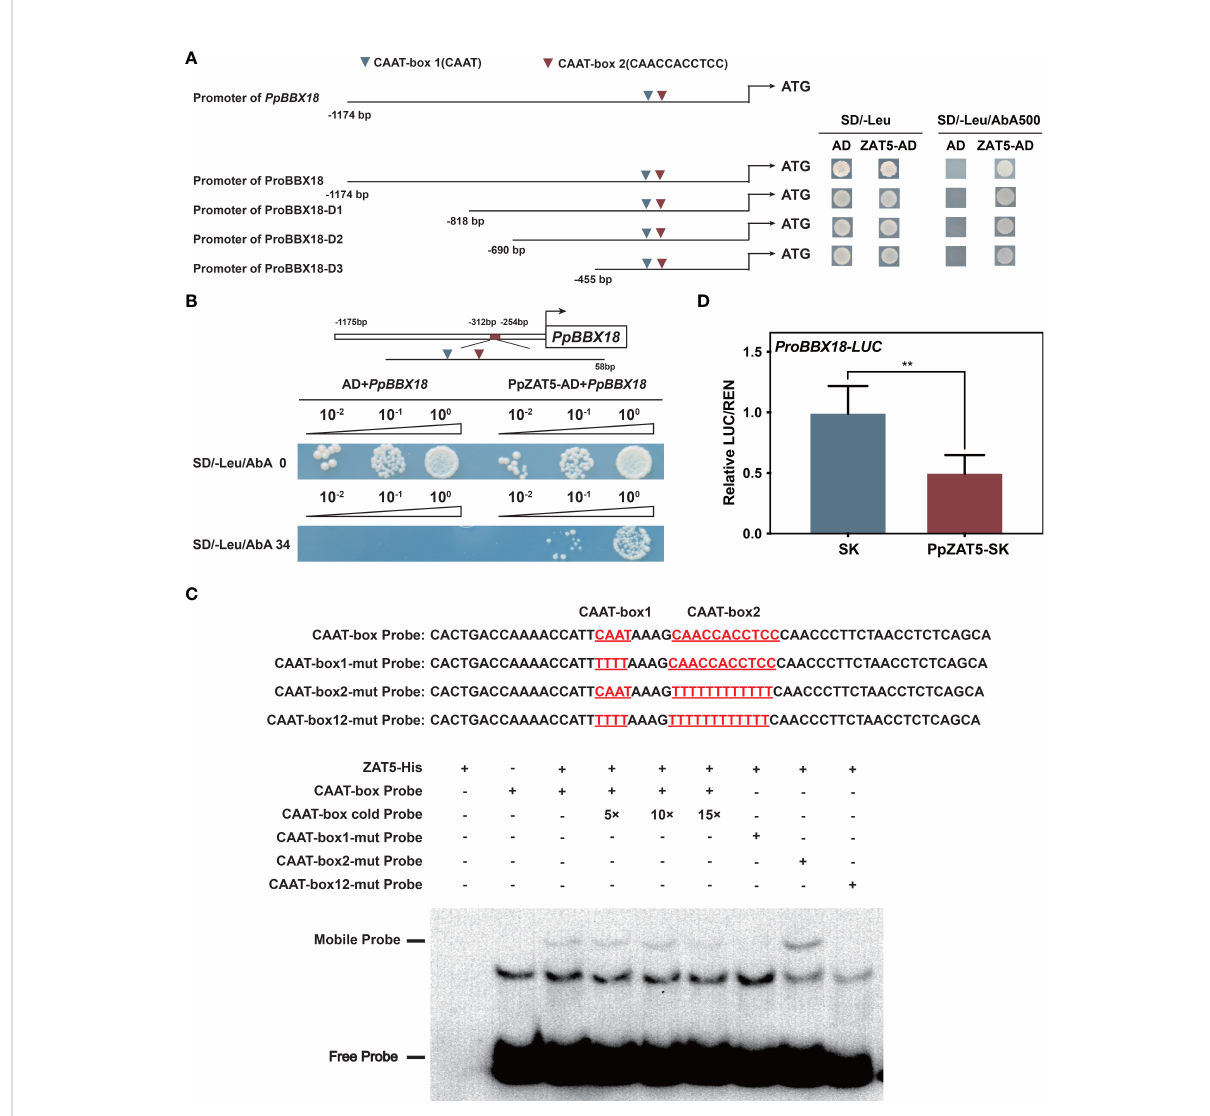
FIGURE 3 PpZAT5 was directly bound to the promoter of PpBBX18 and repressed its expression. (A) Yeast one-hybrid assays of PpZAT5 on a series of fragments of the PpBBX18 promoter. Red triangles indicate CAAT-box 1 (CAAT); Green triangles indicate CAAT-box 2 (CAACCACCTCC) (B) Yeast one-hybrid assays of PpZAT5 on a 58bp fragment of the PpBBX18 promoter, which contains two CAAT-box. (C) Direct binding of PpZAT5 to CAAT-box1 of the PpBBX18 promoter in vitro . (D) A dual-luciferase assay veri fi ed that PpZAT5 reduce PpBBX18 promoter activity. Error bars for dual-luciferase assays represent the standard deviation of three independent experiments each with six technical replicates. Asterisks indicate signi fi cant differences (two-tailed Student ’ s t -test, **P <